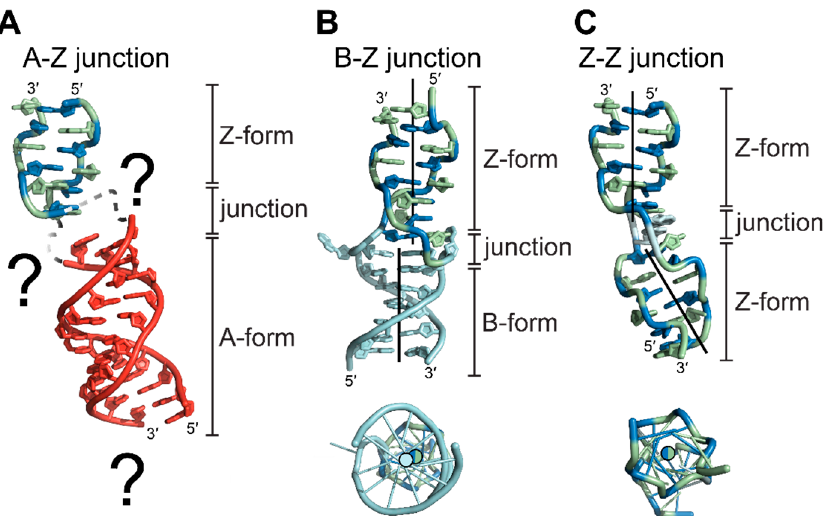
Figure 13. Structures and features of A-Z, B-Z, and Z-Z junctions. Side ( top ) and top-down ( bottom ) views of A-Z junctions (adopted from PDBs 2GXB and 413D for the Z- and A-segments, respectively, [10,48]) B-Z junctions (PDB: 2ACJ [144]), and Z-Z junctions (PDB: 3IRQ [149]). ( A ) The structure of an A-Z junction has not been solved, although characterizations of A-Z junctions suggest they may extend beyond one base pair. The difference in the position of the helical axis is much greater between A- and Z-conformations than it is for B- and Z-conformations (Figure 4), which may partially explain the need for a larger junction segment. ( B ) B-Z junctions facilitate the continuation of base stacking between segments of B- and Z-conformation nucleic acids and can include extruded bases, although this is not always the case. The helical axis between the two segments (solid lines) are only slightly displaced and largely parallel to each other. ( C ) Junction formation is possible between two segments of Z-conformations, excluding a potentially unfavorable nucleotide from adopting the Z-conformation while continuing stacking interactions. The introduction of a junction between two segments of Z-conformation nucleic acids kinks the helical